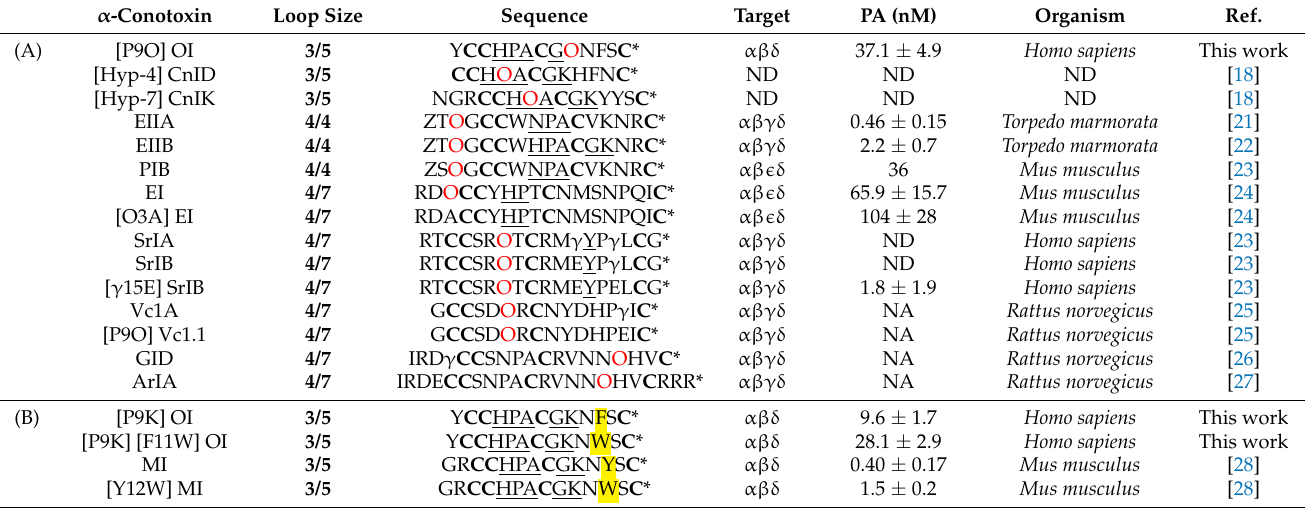
Table 3. Hydroxyproline and tryptophan PTMs and their substitution in α -conotoxins that have muscle nAChR affinity. (A) Comparison between α -[P9O] OI and α 3/5, α 4/4, and α 4/7 sequences with muscle nAChR specificity that contain hydroxyproline. The cysteines are in bold, hydroxypro- lines are highlighted in red, and homologous αα in relation to α 3/5 conotoxins are underlined. (B) Comparison of pharmacological activity of tryptophan substitution in α -MI and α -OI. The cysteines are in bold, and the position of mutation is